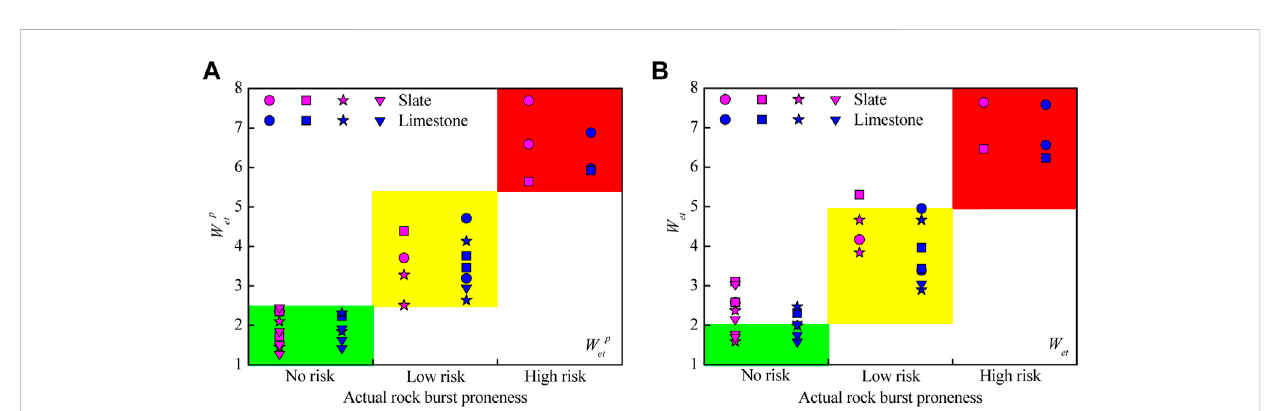
FIGURE 9 (A) Relationship between W p et and actual rock burst proneness and (B) comparison between W et and actual rock burst. Note that the sequence of symbols of slate and limestone corresponds to the increasing L/D ratio.